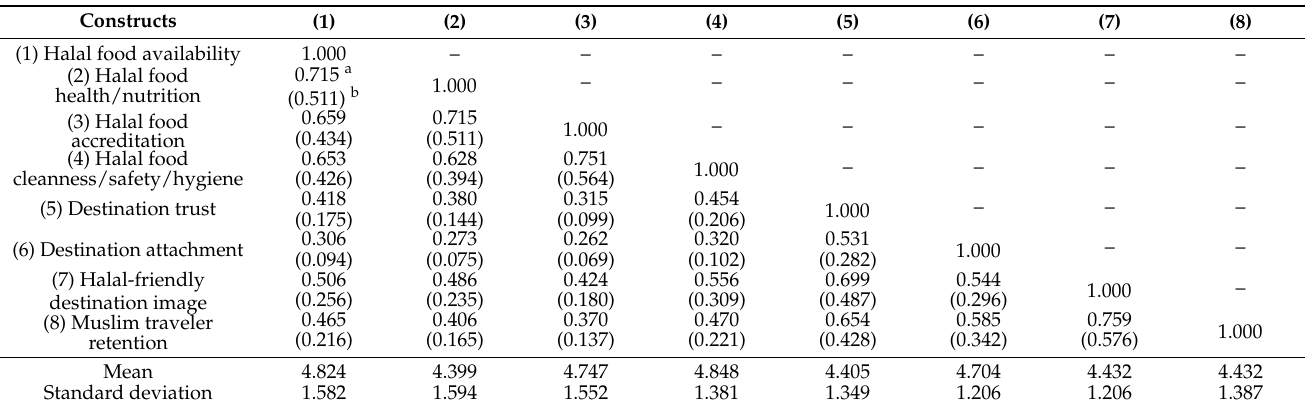
Table 2. Measurement model and data quality assessment results ( n =